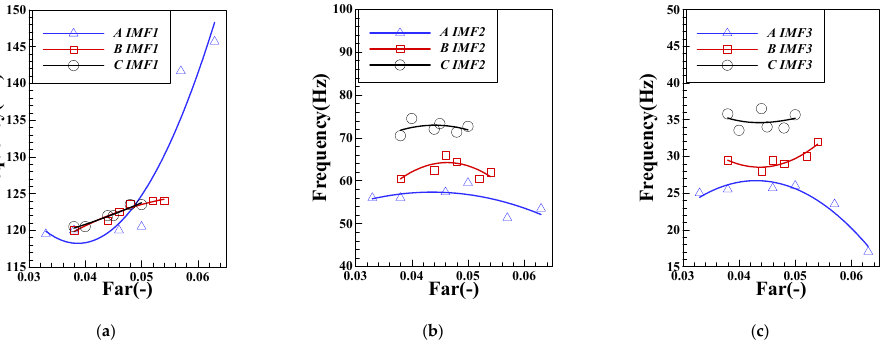
Figure 18. Variation of the pulsation dominant frequency of the DP components:( a ) IMF1; ( b ) IMF2; ( c ) IMF3.